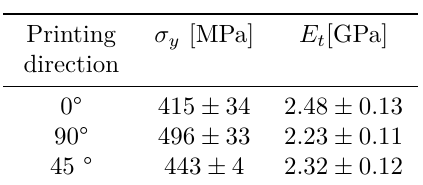
Table 2. Mean values and standard deviation of Young’s modulus and Yield strength evaluated from quasi-static experiments